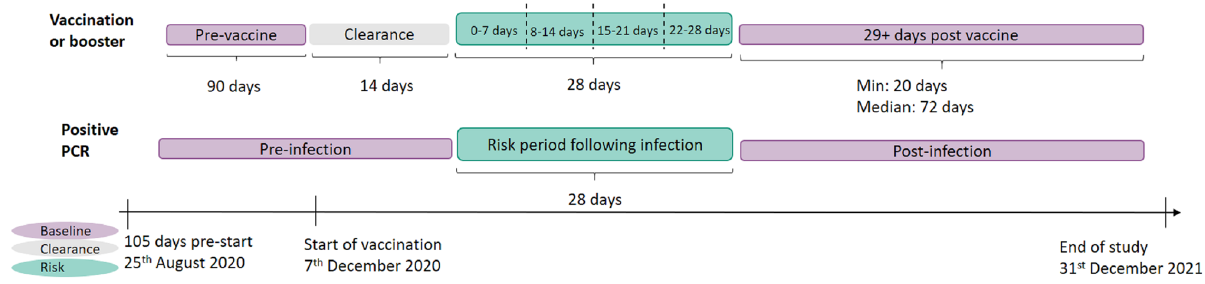
Figure 1. Self-controlled case series study design by vaccination status and positive PCR test status,